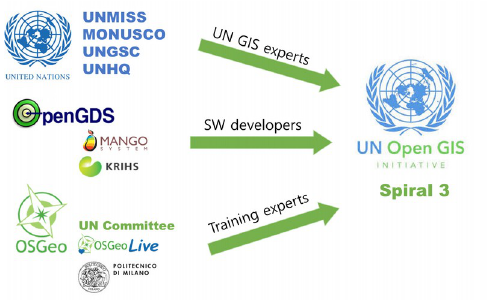
Figure 4. collaboration structure of UN Open GIS Initiative - Spiral 3.